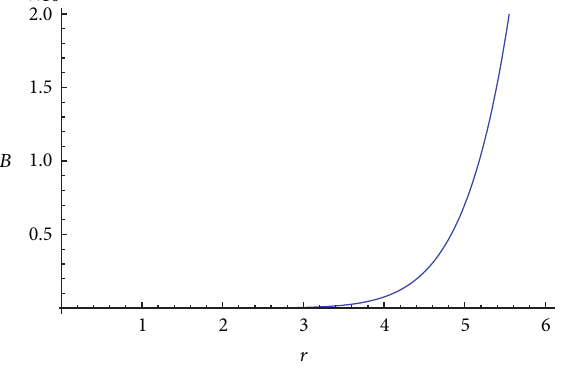
Figure 6: Dominant energy condition.